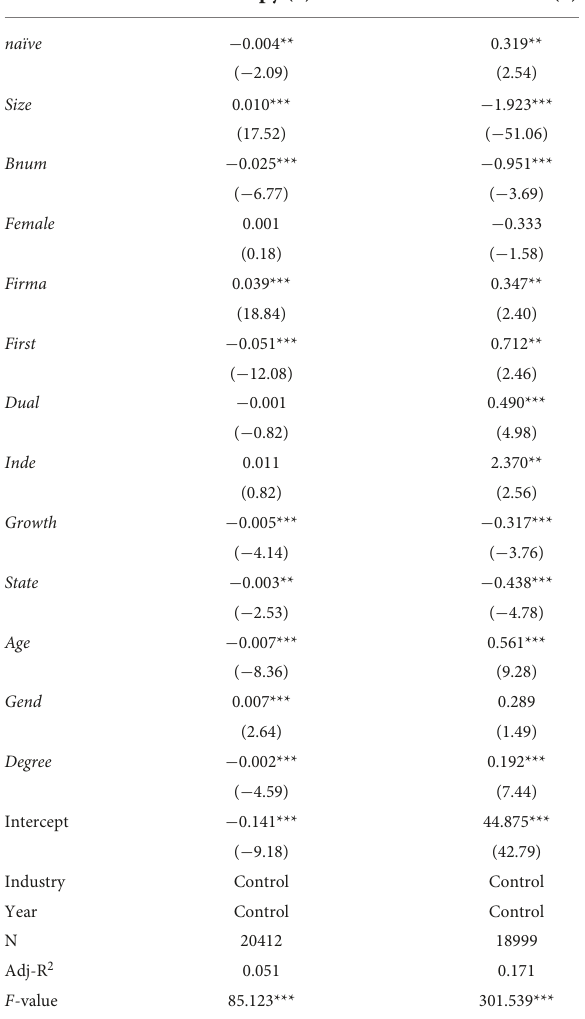
TABLE 6 Regression results of Naives and the tunneling and financial